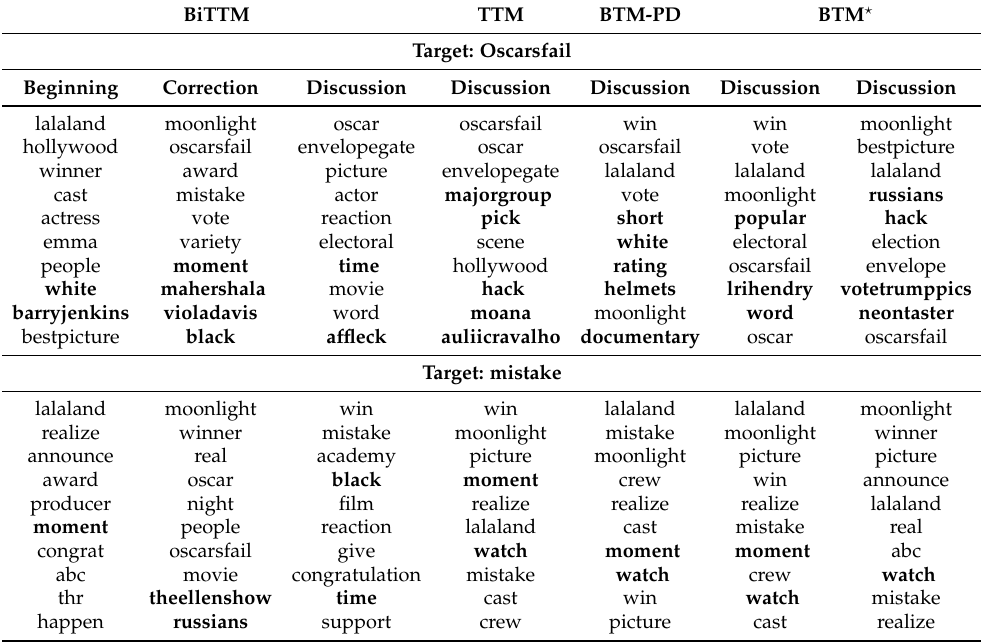
Table 9. The contents of topics on two approximate semantic targets in dataset “Oscars”.